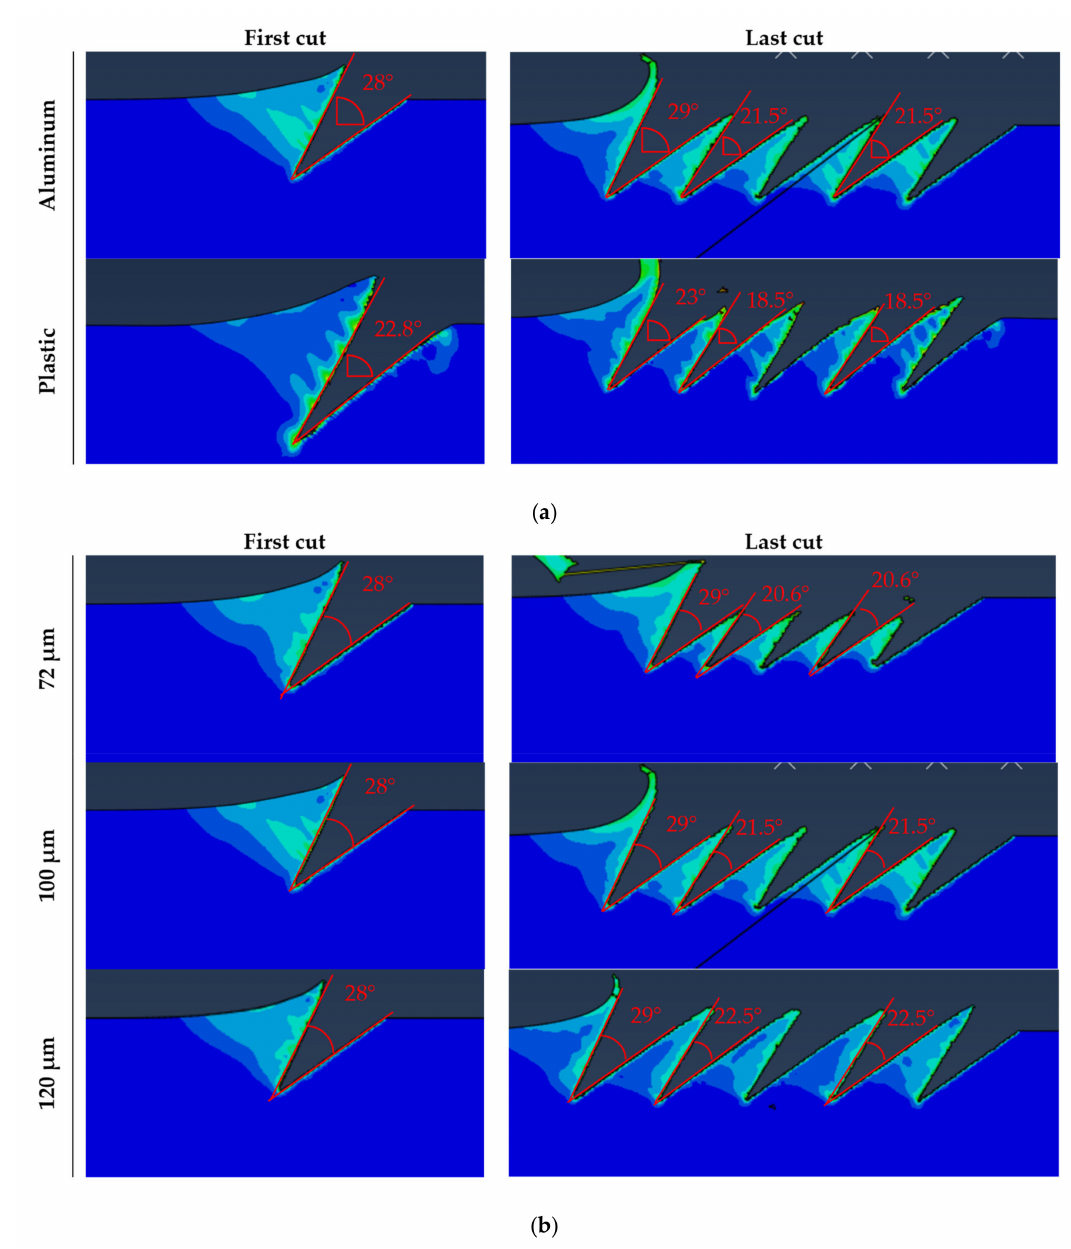
Figure 11. ( a ) . Interference between subsequent passes for two different materials simulated with Abaqus with 100 µ m spacing. ( b ). Interference between subsequent passes for aluminum as a function of spacing between passes simulated with